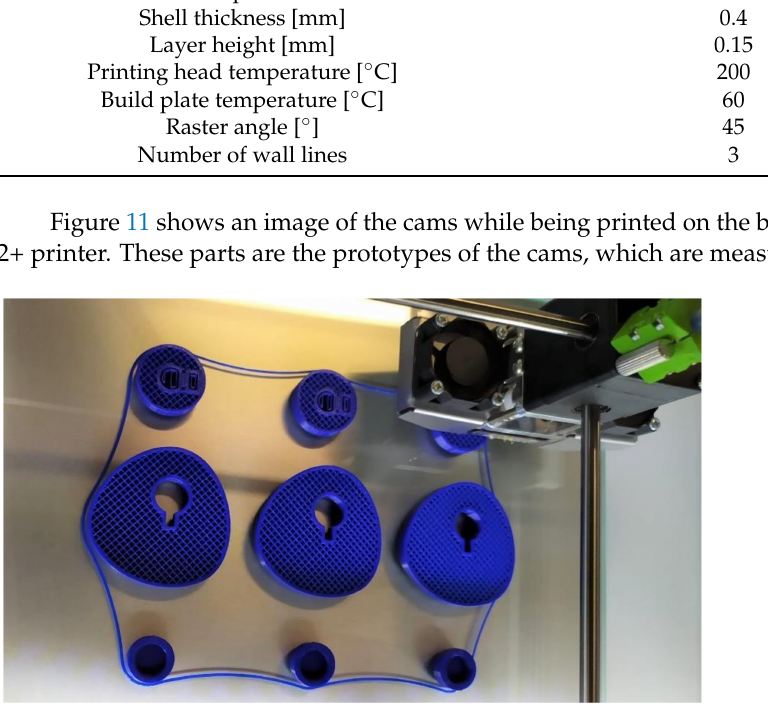
Figure 11. Constant-breadth cams being printed on the bed of the printer Ultimaker